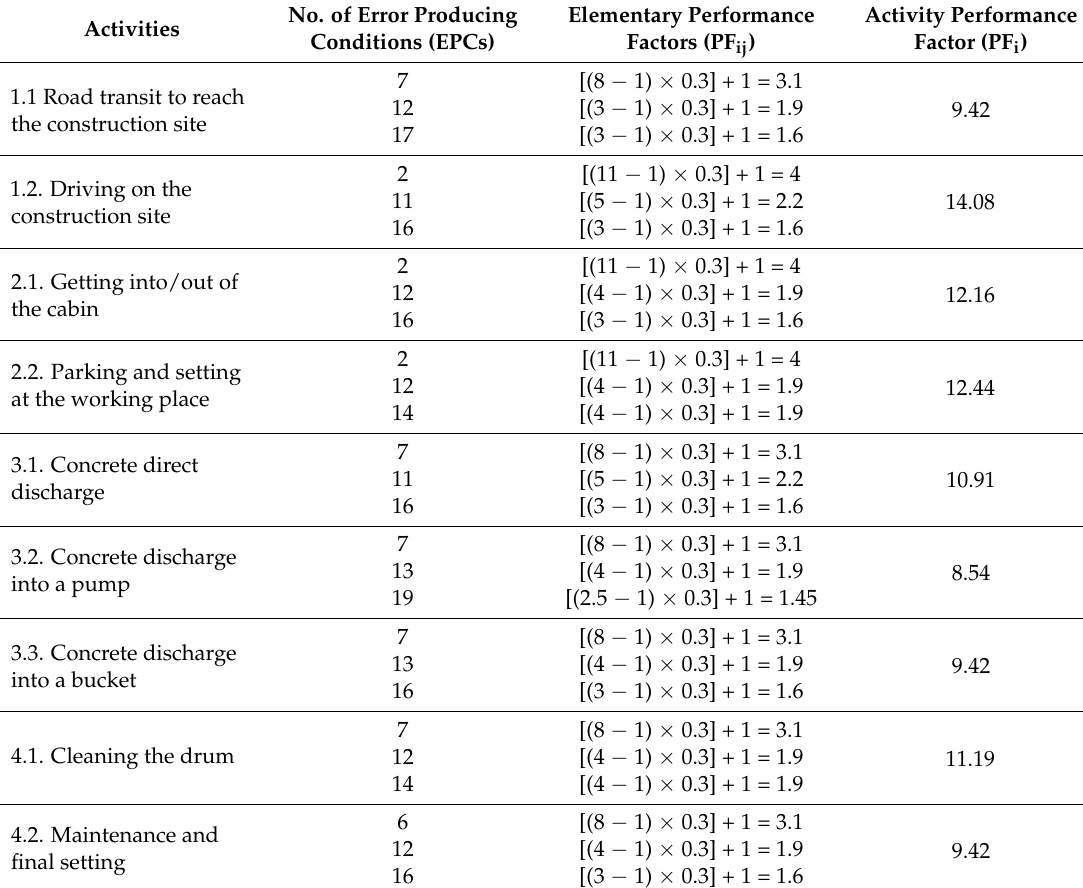
Table 3. Computation of the performance factors (PFs) for each activity (PF i